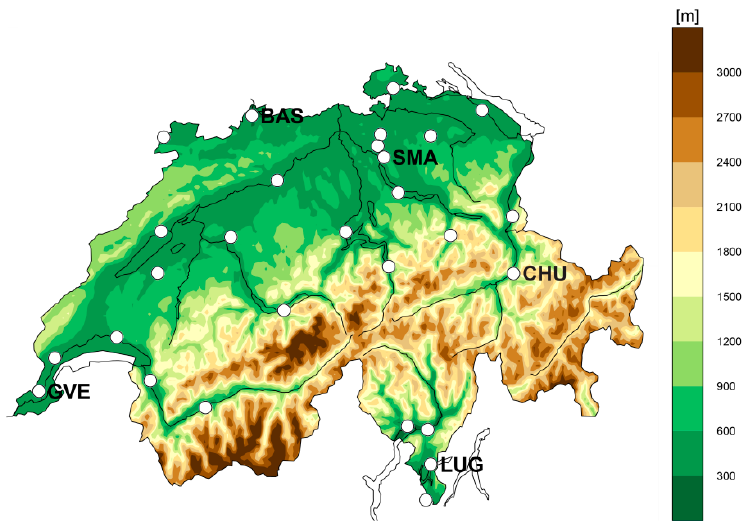
Figure 1. Location and elevation of the 28 considered automated stations of the Swiss national weather service MeteoSwiss (SwissMetNet stations). The selected sites are consistent with the heat warning-relevant elevation of < 600 m [48]. The stations Basel (BAS), Chur (CHU), Geneva (GVE), Lugano (LUG) and Zurich Fluntern (SMA) serve as exemplary sites for later analyses.